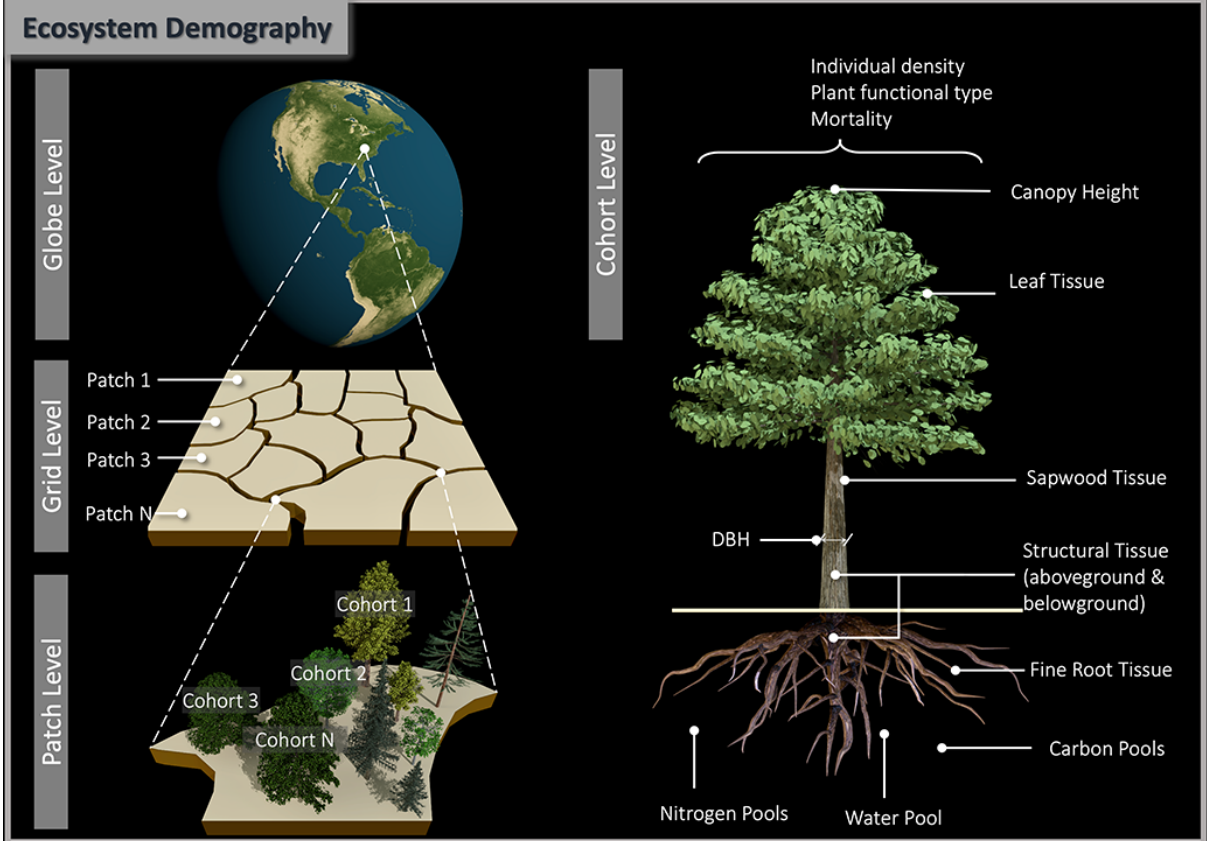
Figure 1. Diagram of the vegetation representation scheme in the ED model. Globe consists of land grids with a fixed spatial resolution. A grid consists of patches with different ages from last disturbance and land-use types, and patch areas dynamically change over time as a result of disturbance and land-use changes. A patch consists of different plant functional types and sizes. Plants in a cohort are depicted by properties including individual density, canopy height, diameter at breast (DBH), and biomass in leaf, sapwood, structural tissue and fine roots, and all these properties are simulated as a result of interactions with the environment and other cohorts. Note that not all properties are shown